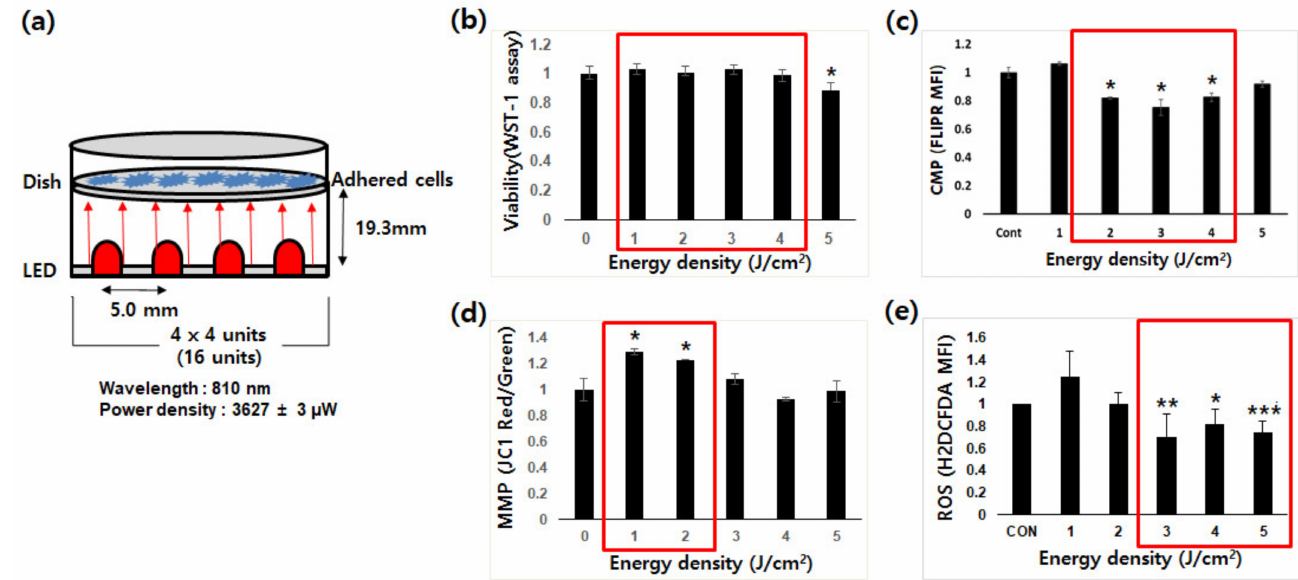
Figure 1. NIR-modulated plasma membrane potential and intracellular ROS of HeLa cells in a dose-dependent manner. ( a ) Schematics of the NIR irradiation device. ( b ) Relative viability (WST-1 assay) according to NIR irradiation dose (time) after 6 h from irradiation. ( c ) Relative MFI of FLIPR dye right after irradiation. ( d ) Relative MFI of JC-1 dye (red/green) right after irradiation. ( e ) Relative MFI of H2DCFDA dye right after irradiation (* p < 0.05, ** p < 0.01, *** p < 0.001 with students’ t -test ( n =